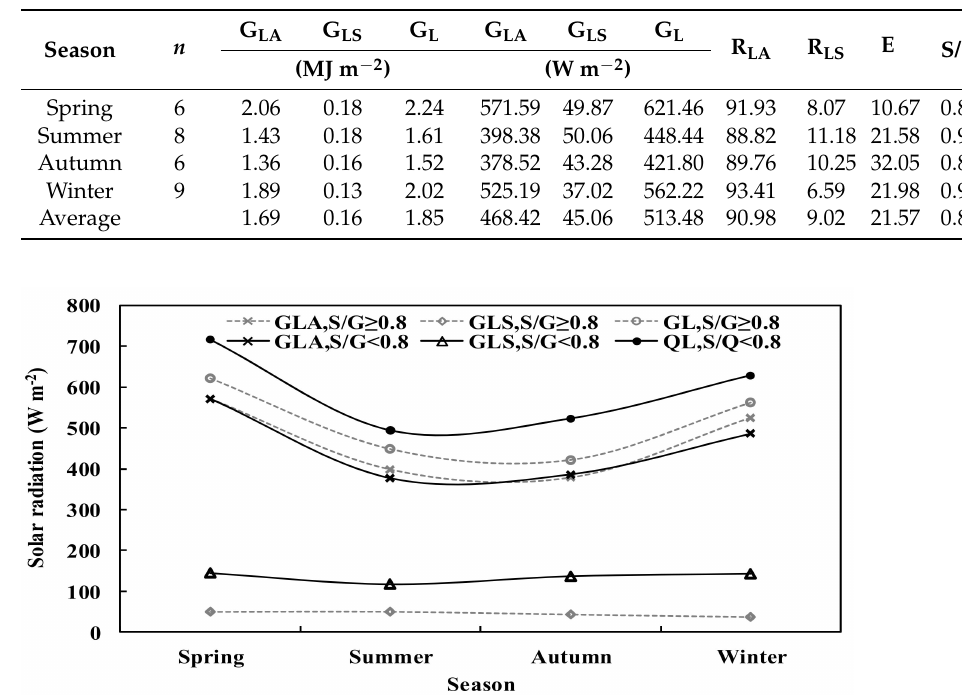
Figure 3. Seasonal mean losses of global solar radiation (W m − 2 ) caused by absorbing and scattering substances (G LA and G LS ) and total loss (G L ) for S/G < 0.80 and S/G ≥ 0.80. G LA clearly varied with the seasons (e.g., higher in spring and lower in summer),